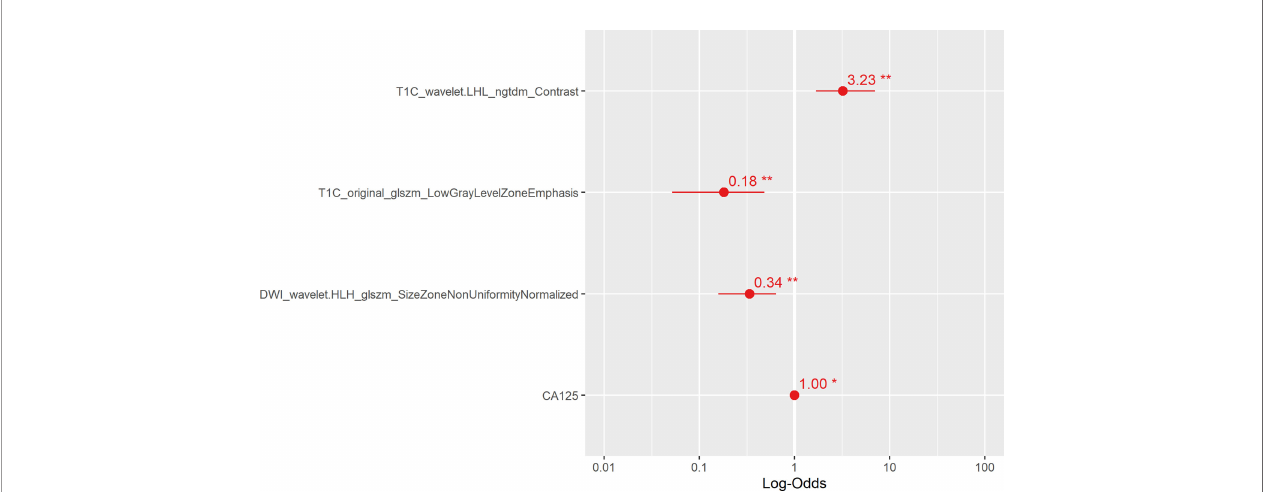
FIGURE 4 | The main radiological features extracted in this study and the results of multiple logistic regression of preoperative CA125. The horizontal line is the 95% con fi dence interval of the study, and the small dot in the center of the horizontal line is the point of the OR